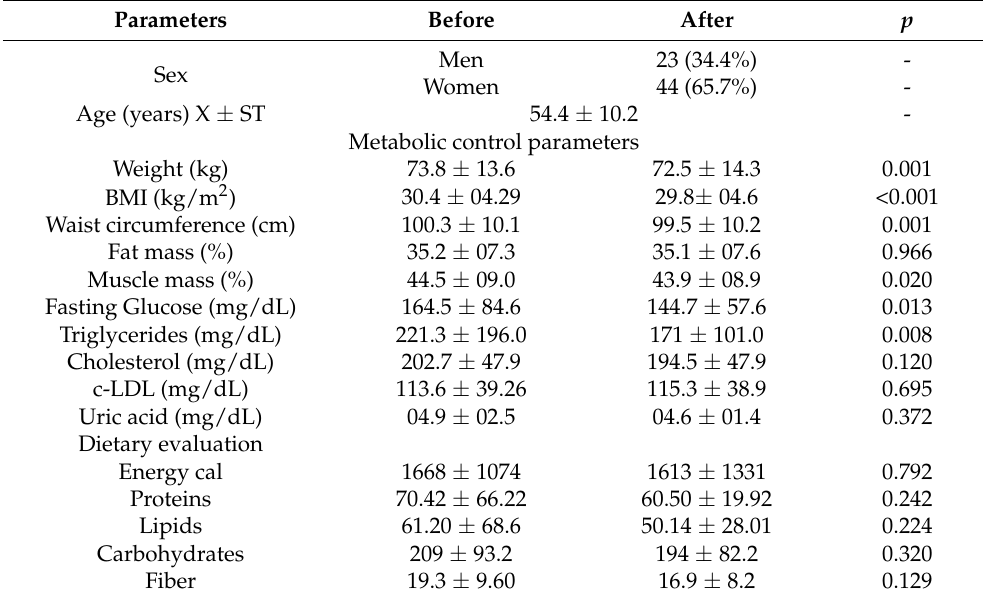
Table 1. Characteristics of study population before and after agave inulin intervention.